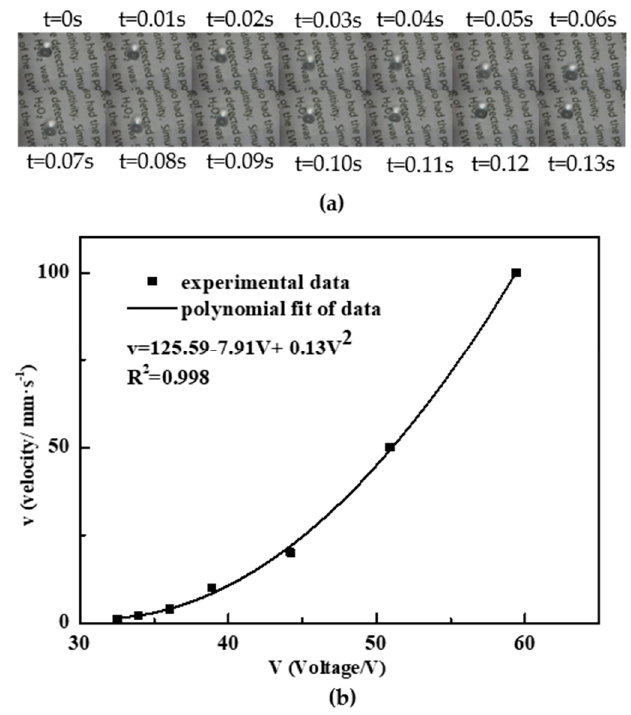
Figure 6. Electrowetting transportation test: ( a ) images of droplet transportation; ( b ) droplet velocity versus voltage (r.m.s).